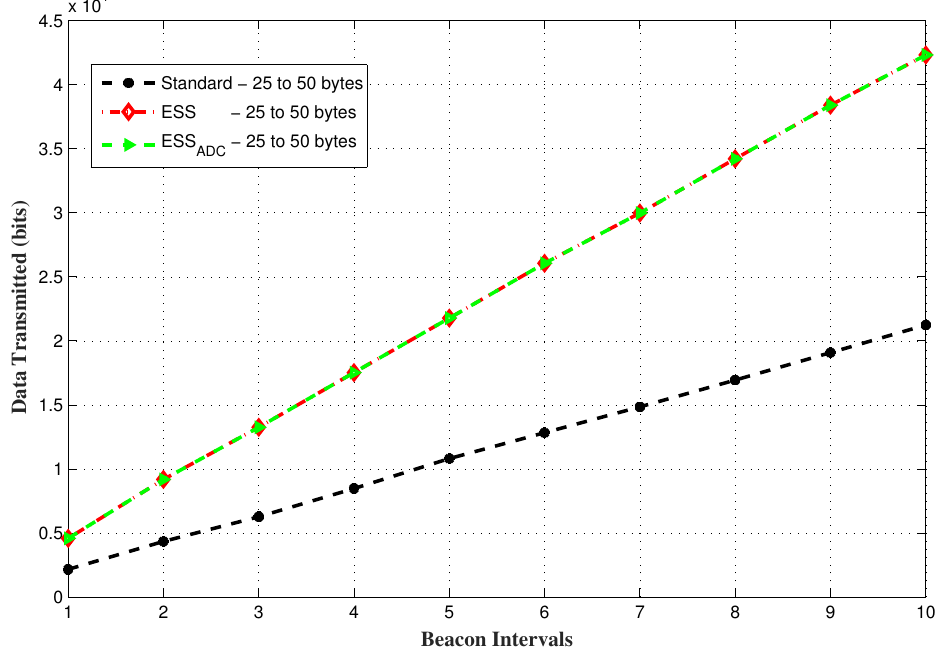
Figure 10. Data transmission by all nodes for random data requesting